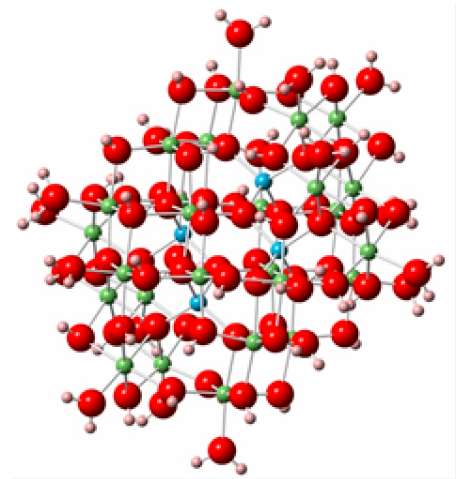
Figure 2. The Ga 30 cluster shown in ball-and-stick formalism and in a similar orientation as in the previous figure. Red spheres are oxygens, white are protons and Ga(III) are green if octahedrally coordinated and blue if tetrahedrally coordinated. The cluster stoichiometry